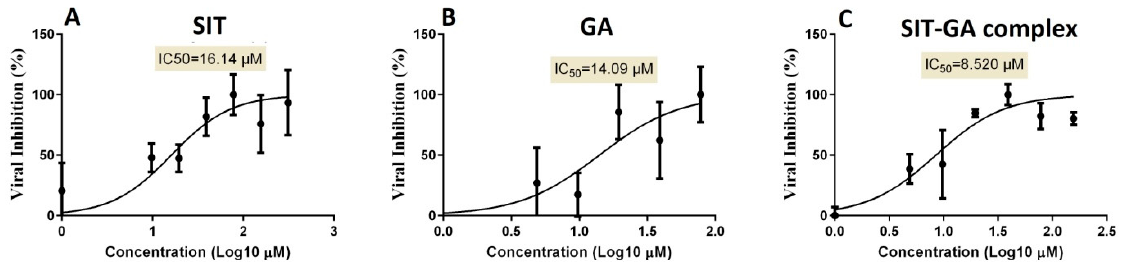
Figure 6. Determination of the half-maximal inhibitory concentration (IC 50 ) of ( A ) SIT, ( B ) GA, and ( C ) SIT-GA nano-conjugates against SARS-CoV-2 (Vero-E6 infected cells).